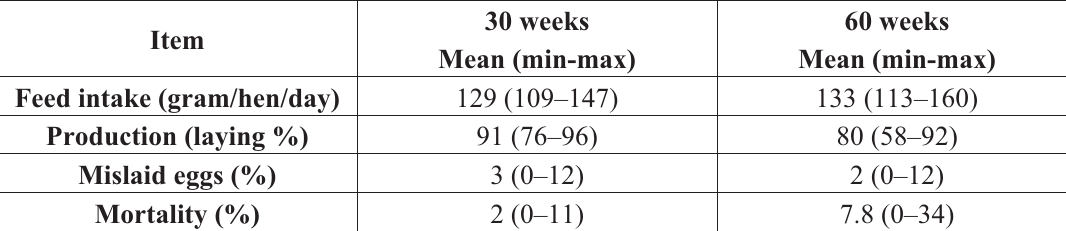
Table 5. Production parameters at 30 and 60 weeks of